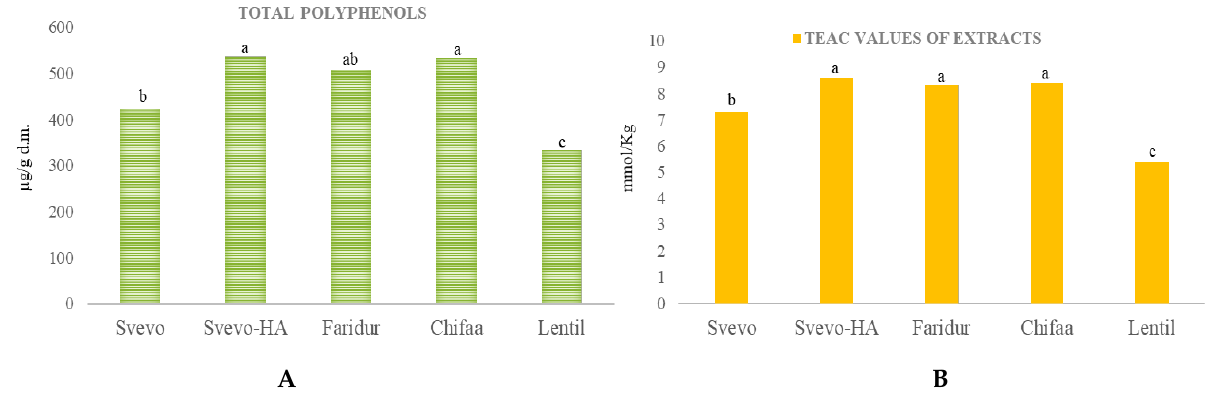
Figure 2. Total polyphenols (µg/g dry matter) resulting from the sum of the individual phenolic acids and flavonoids detected in the wholemeal flours of Svevo, Svevo-HA, Faridur, Chifaa and lentils 6002/ILWL118/1-1 ( A ); and antioxidant activity of the extracts (mmol Trolox equiv/Kg). ( B ) a–c Different letters for each phenolic acid indicate significant differences between the samples ( n = 3, p < 0.05).